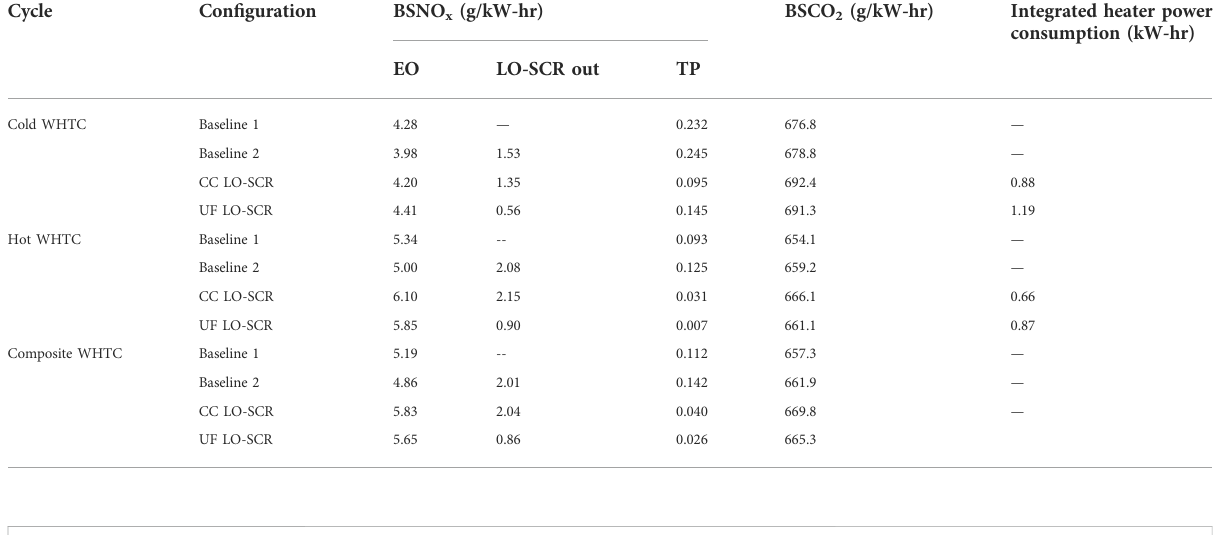
TABLE 11 Composite WHTC, cold WHTC and hot WHTC test results.